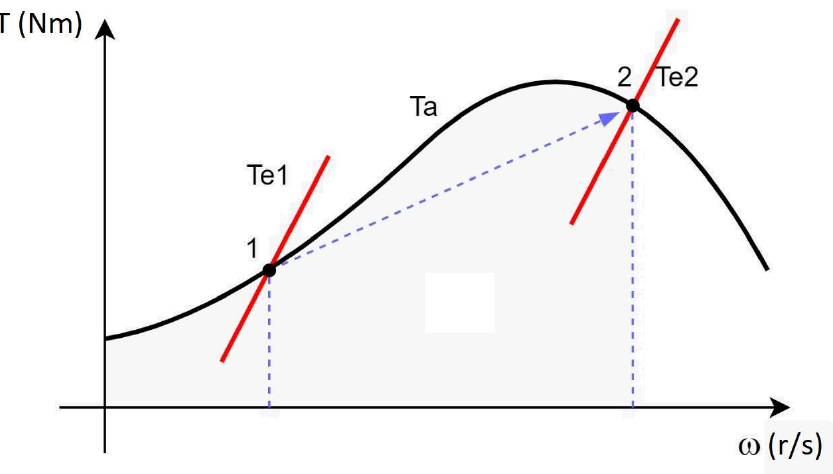
Figure 21. Possible working points of the system, based on the aerodynamic torque of the wind turbine relative to the electromagnetic torque imposed by the solar